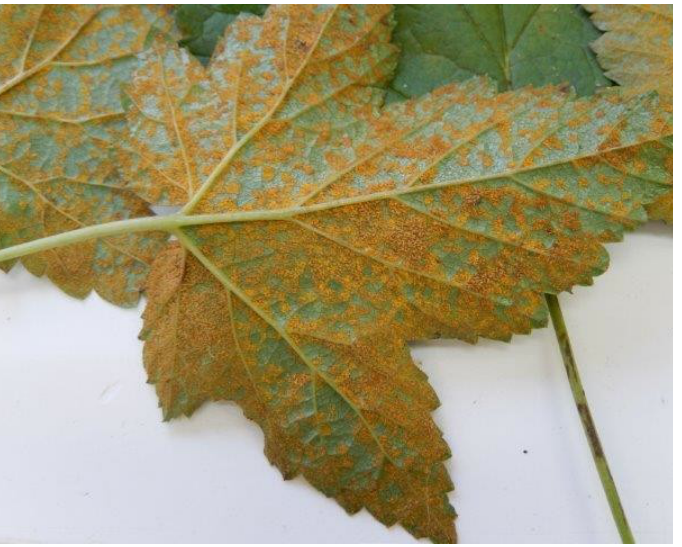
Figure 2. White pine blister rust, caused by Cronartium ribicola , on bole of sugar pine ( right ) and Ribes leaf ( left ). The pathogen, C. ribicola is similar to C. quercuum f.sp. fusiforme, but alternates between the leaves of Ribes and needles (and eventually stems) of white pines ( Pinus section